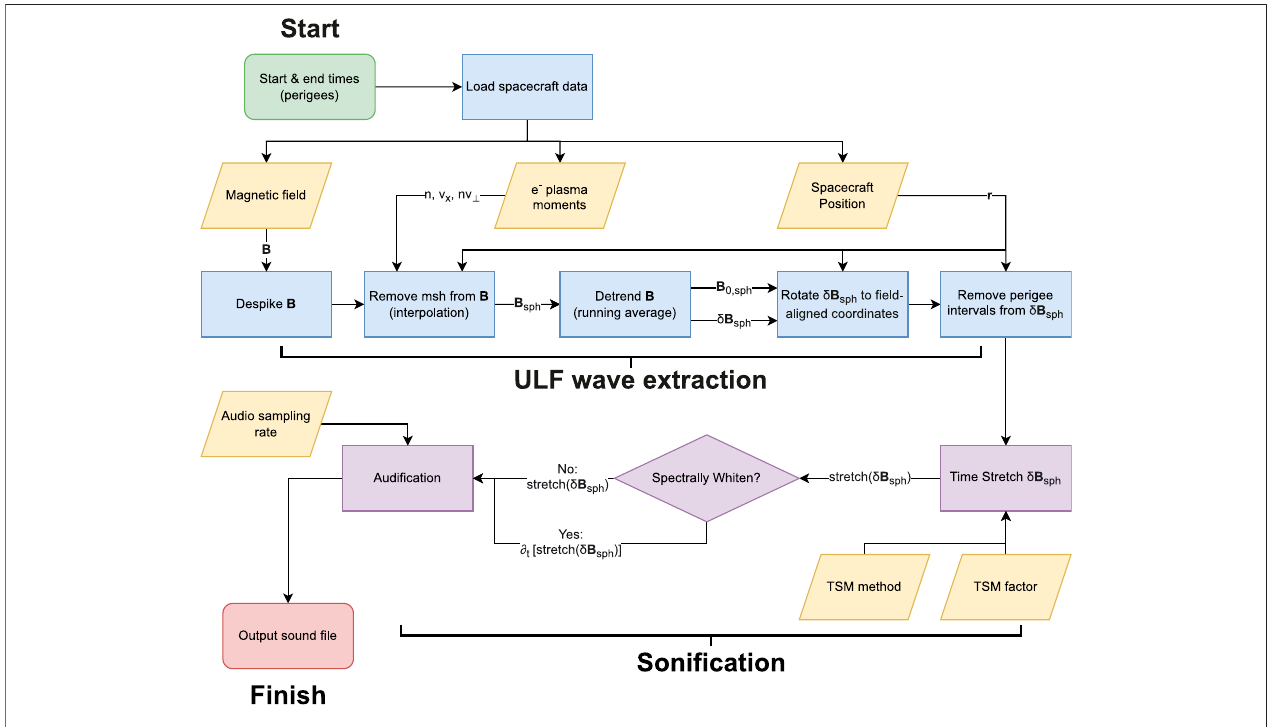
FIGURE 2 | Flow chart of the soni fi cation processes